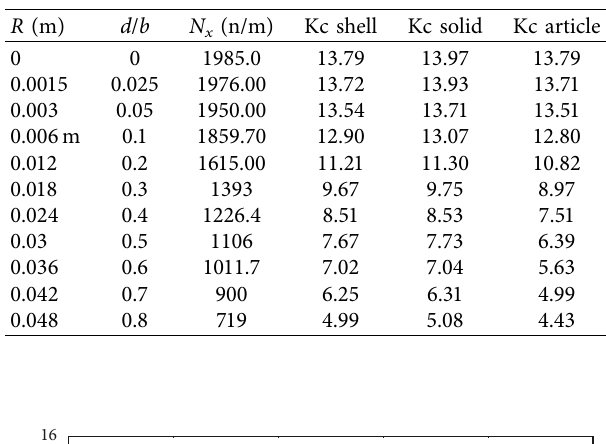
Table 9: Comparing dimensionless values of critical tension load for shell and solid elements.